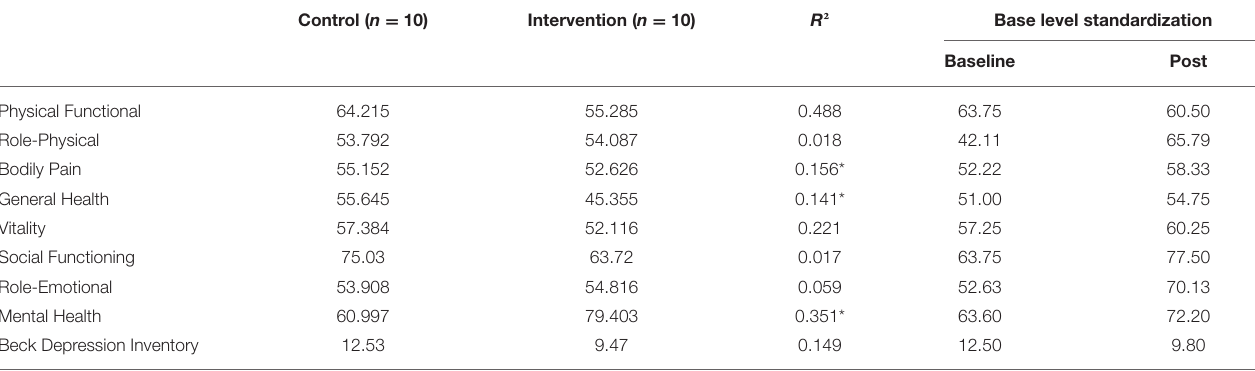
TABLE 5 | Adjustment measures for the ANCOVA models ( n = 20) when comparing the control group (no treatment) and the intervention one, during the follow-up, in relation to the quality of life questionnaire SF-36 and the Beck Depression